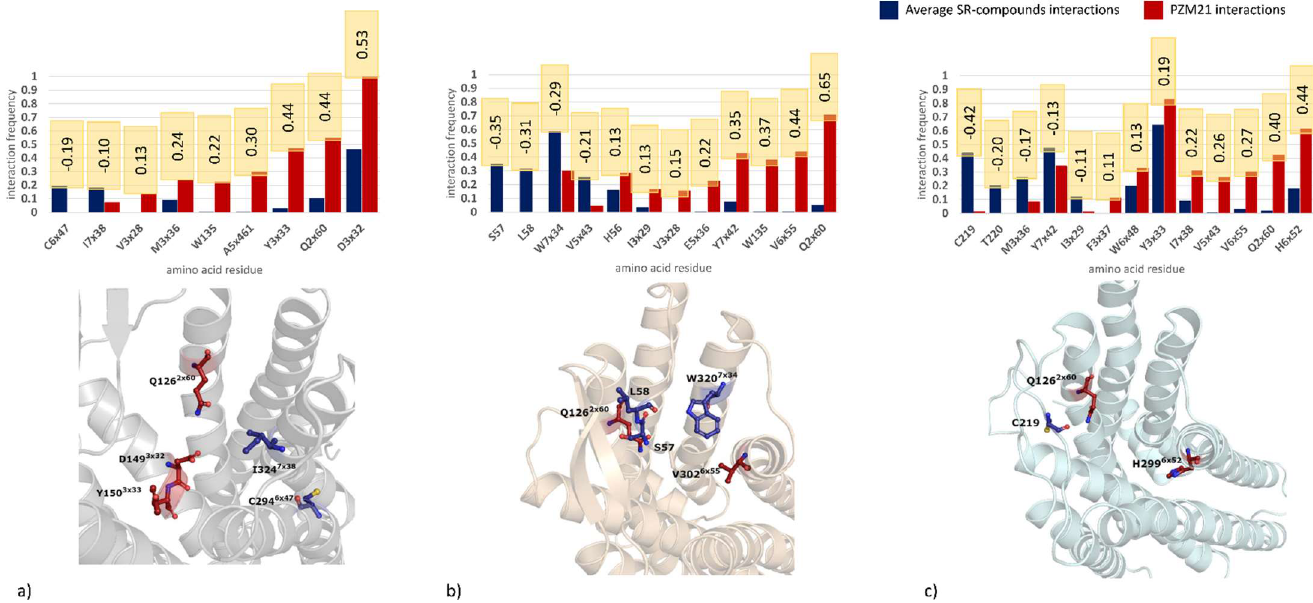
Figure 9. Analysis of residues with the highest discriminative power between the SR compounds and PZM21 for ( a ) 4DKL, ( b ) 5C1M, ( c ) 6DDF crystal structures; numbers in orange boxes refer to differences in the interaction frequencies between PZM21 and SR compounds. Example residues are